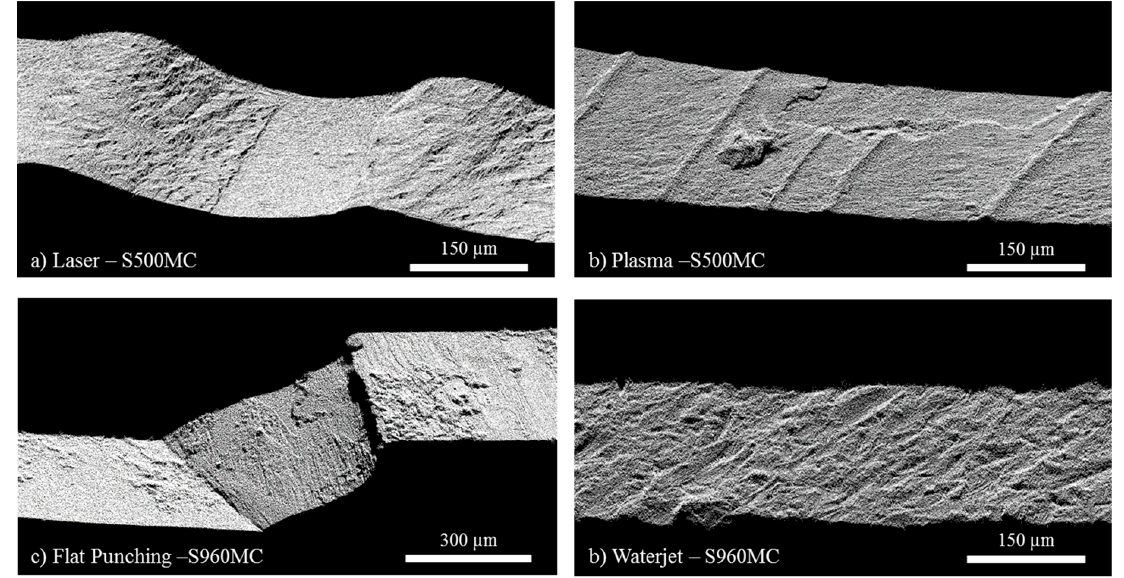
Figure 8. Surface profile of ( a ) laser-cut hole (S500MC), ( b ) plasma-cut hole (S500MC), ( c ) flat punching (S960MC), and ( d ) waterjet-cut hole.